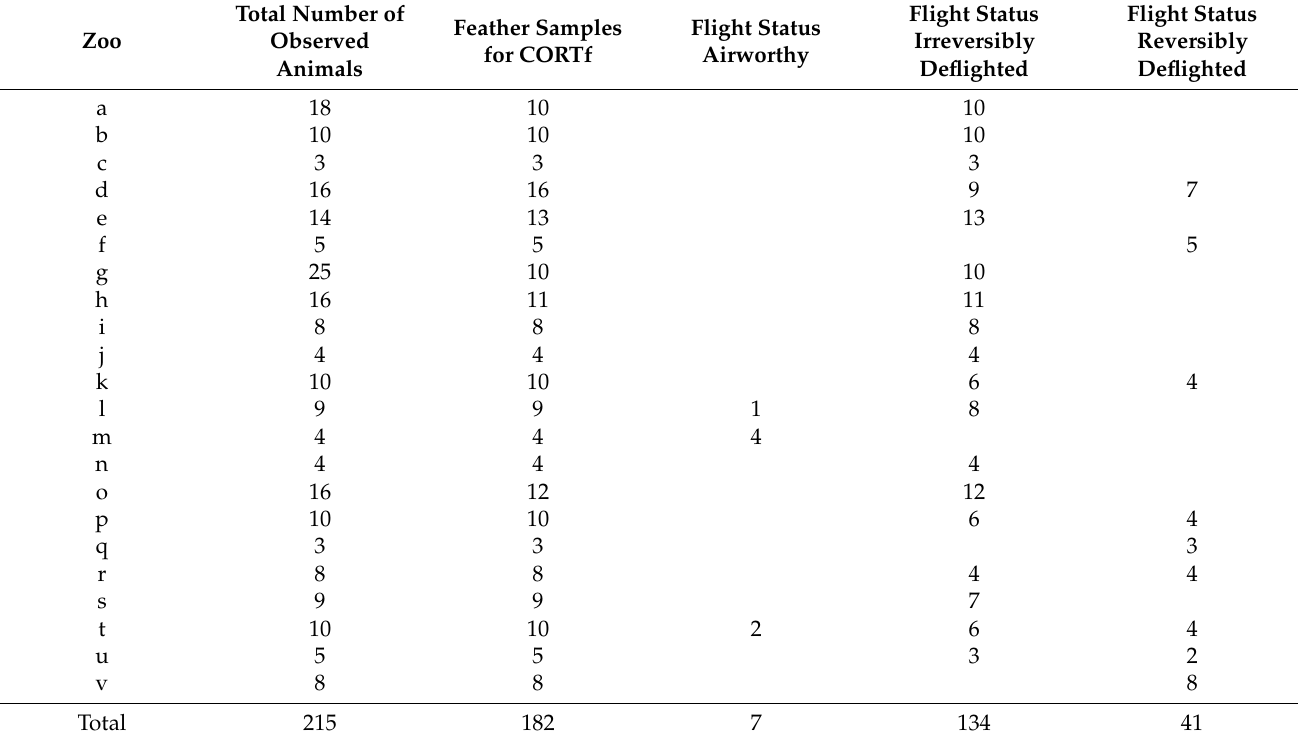
Flight Status Airworthy